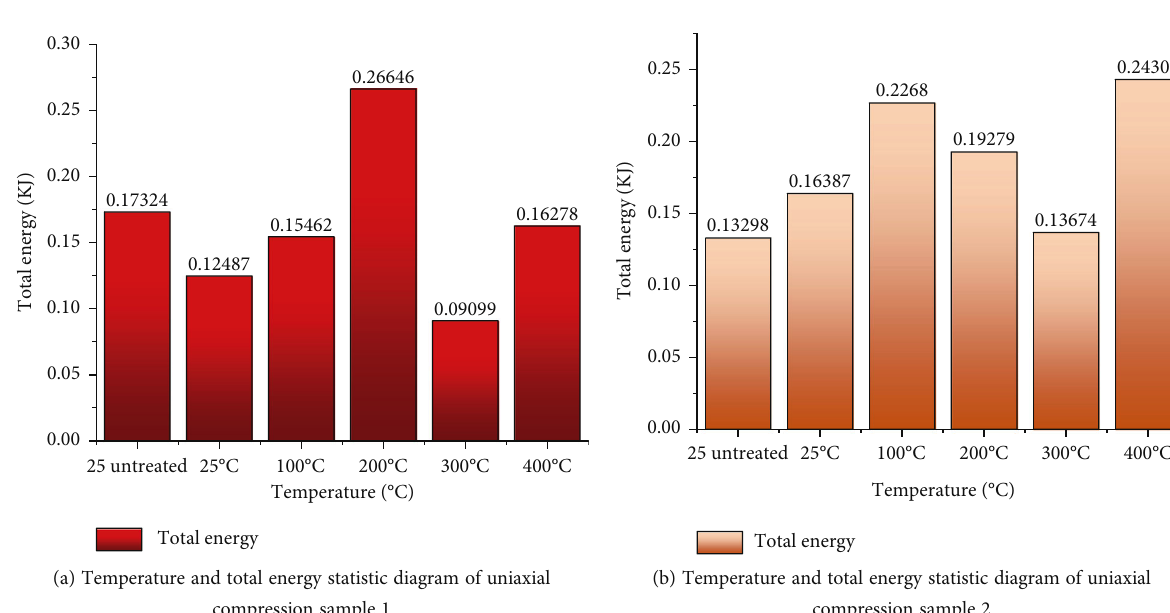
Figure 14: Axial load energy curve of Brazil splitting test.